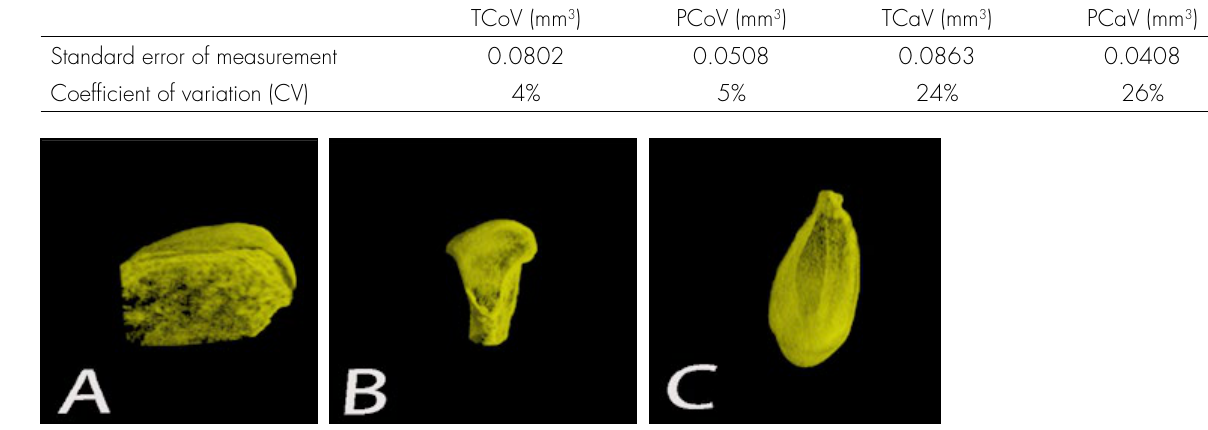
Table I. Error of